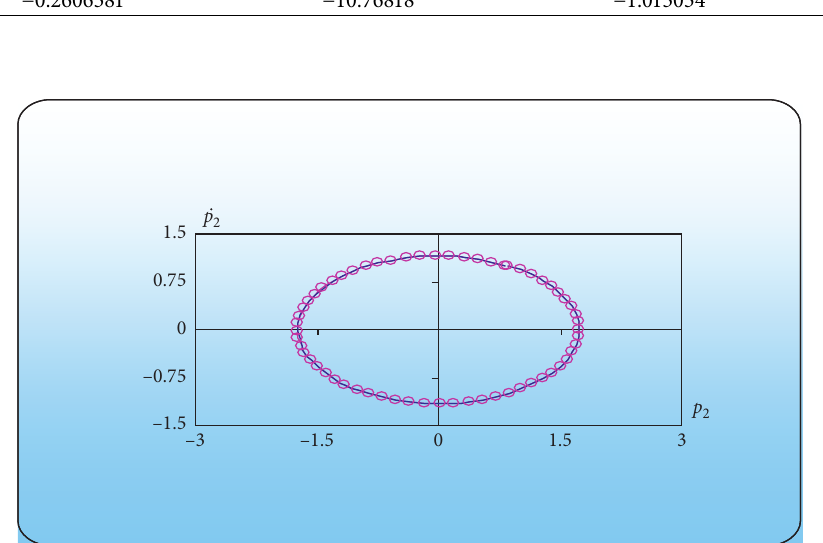
Figure 3: The stability of the analytical and numerical solutions _ p